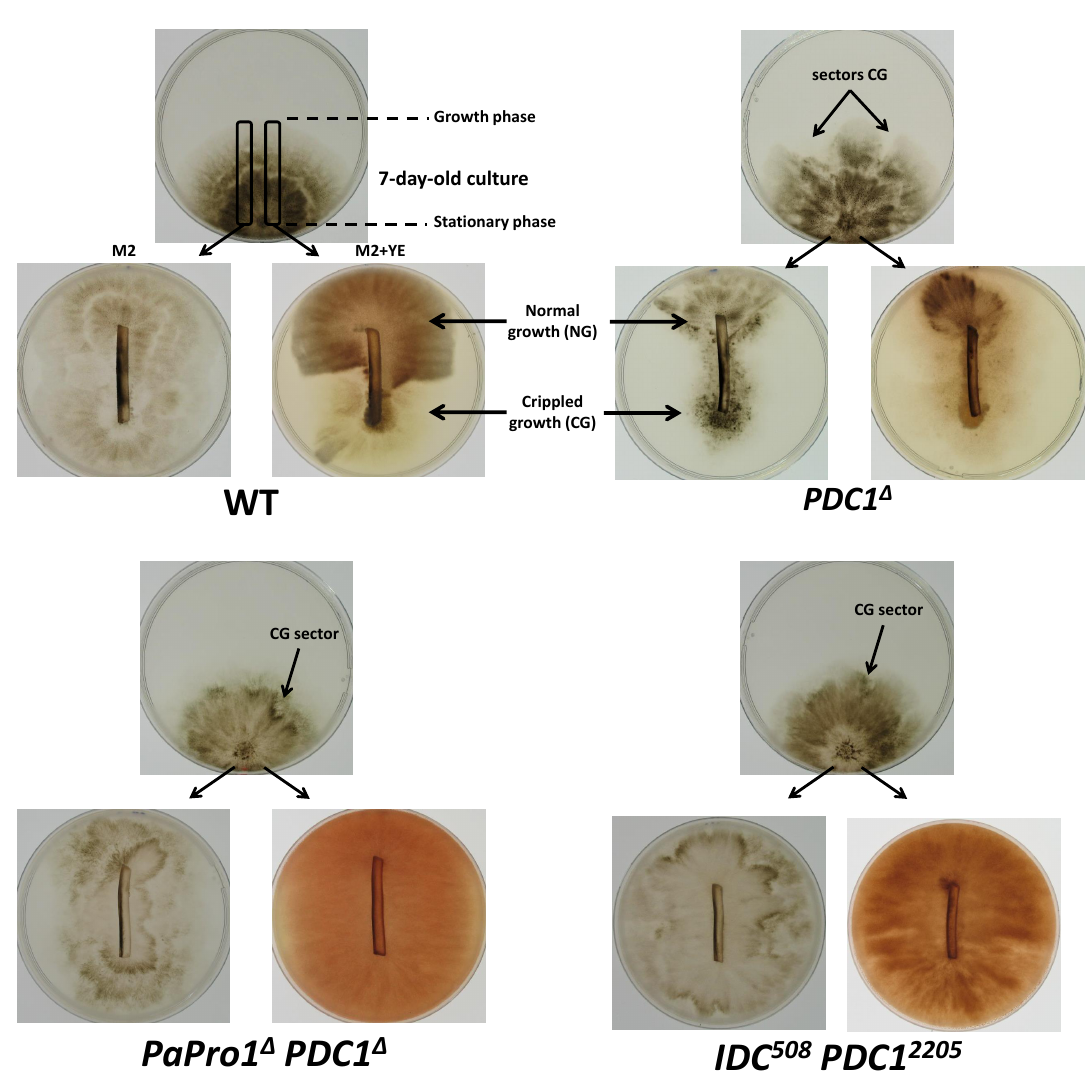
Figure 8. Epistasis analysis with PDC1 mutants. CG test were made as in Figure 1, i.e., slices were taken on seven-day-old mycelia with the indicated genotypes and reinoculated either on M2 or on M2 containing YE. Pictures were taken seven days later. For the wild-type this resulted in the development of CG only on medium containing YE, whereas for the PDC1 ∆ mutant, CG developed on both media. The PaPro1 ∆ PDC1 ∆ and IDC 508 PDC 2205 double mutants exhibited spontaneous CG sectors on M2, but could not be induced to present CG after passage into stationary